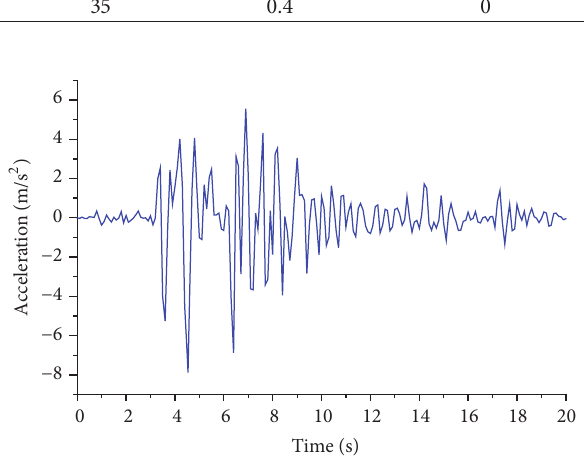
Figure 11: Acceleration-time curve of the KOBE